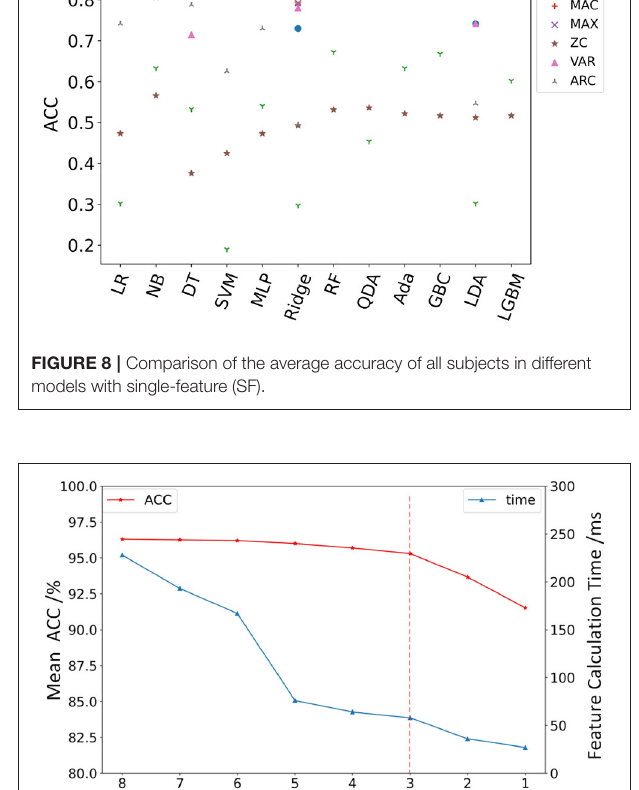
multiple classifiers. The features used in the online phase